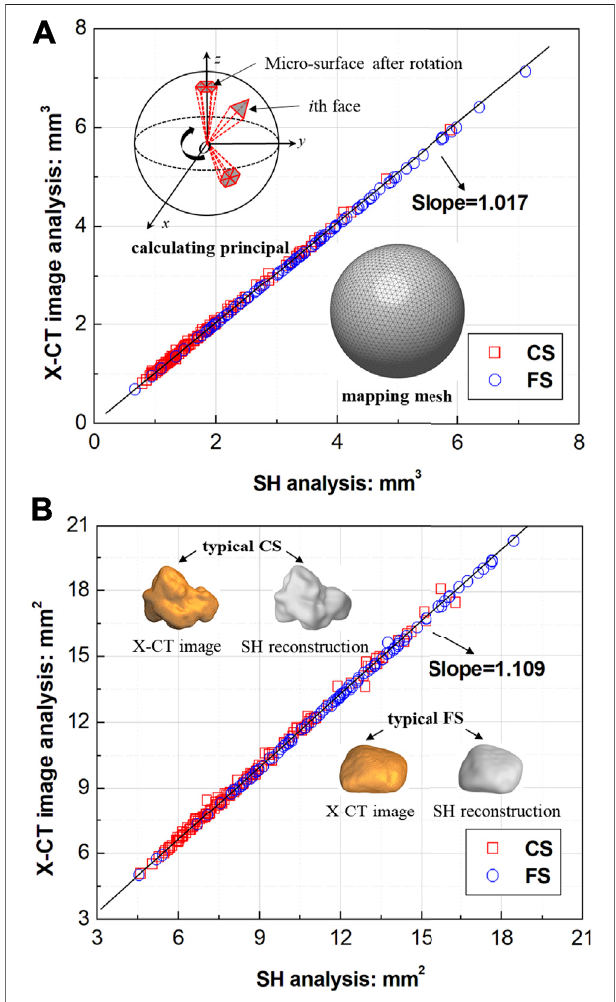
FIGURE 1 | Mapping mesh and computational algorithms and results comparison with the SH degree of 15: correlation between the results of (A) particle volume, (B) surface area by SH analysis and by image